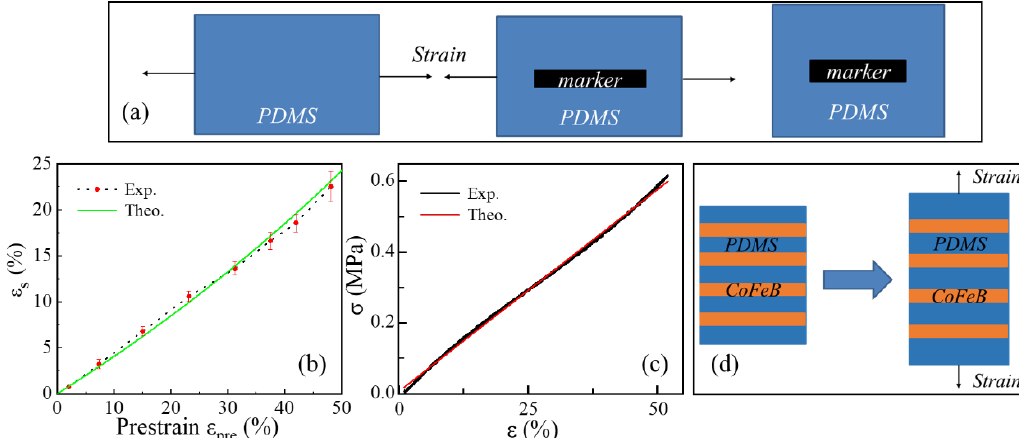
Figure 4. ( a ) Poisson’s ratio ( ν ) of polydimethylsiloxane (PDMS) substrate is calculated by measuring the change of marker width on PDMS when releasing prestrain. ( b ) PDMS substrate Poisson’s ratio test results: the red point is the experimental data, the green curve is the theoretical fitting value when ν = 0.4. ( c ) PDMS tensile curve; when the tensile amount is 0–50%, the Young’s modulus is 1.14 MPa by fitting, and the red curve is the theoretical fitting. ( d ) The mechanical properties of the Ta/CoFeB/Ta thin films are calculated by measuring the strain of the film during the tensile process.